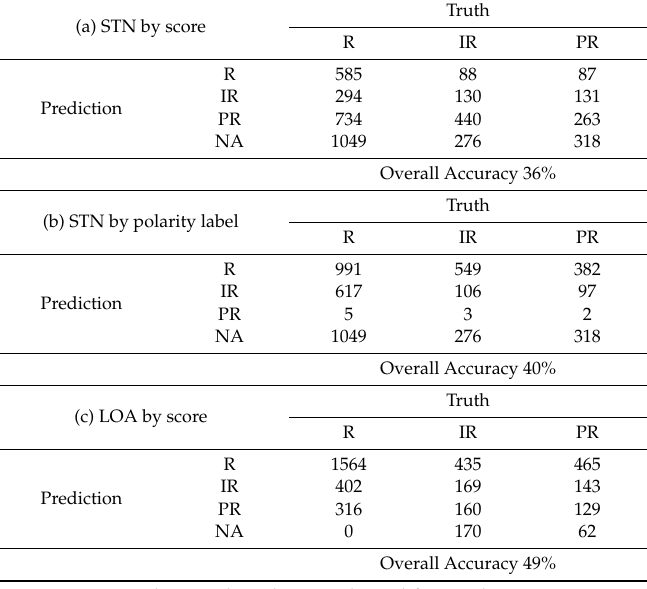
Table 2. The confusion matrices of sentiment analysis for fine-grained filtering by ( a ) SentiTurkNet (STN) by score, ( b ) STN by polarity label, and ( c ) the Lexicon of Ozturk and Ayvaz (LOA) by score. Truth (a) STN by score R IR PR R Prediction